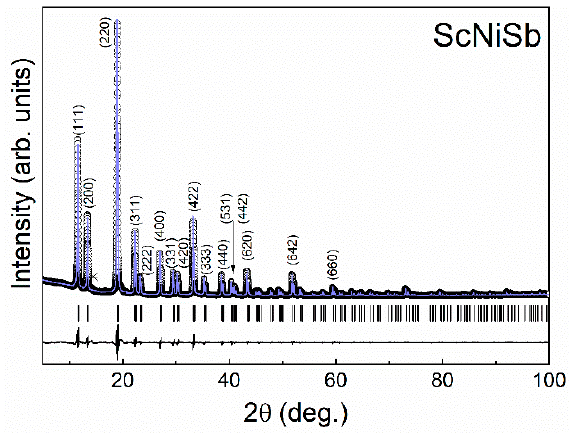
Figure 1. X-ray diffraction pattern of the half-Heusler compound ScNiSb (Mo K α radiation). The solid line through the experimental points represents the refinement profile. Black ticks show the angular positions of the reflections of the ScNiSb phase. The asterisk marks a strongest reflection due to the Sc 2 O 3 phase. The difference pattern is shown as a black solid line on the bottom. Table 1. Microstructural parameters determined for the studied sample of ScNiSb.